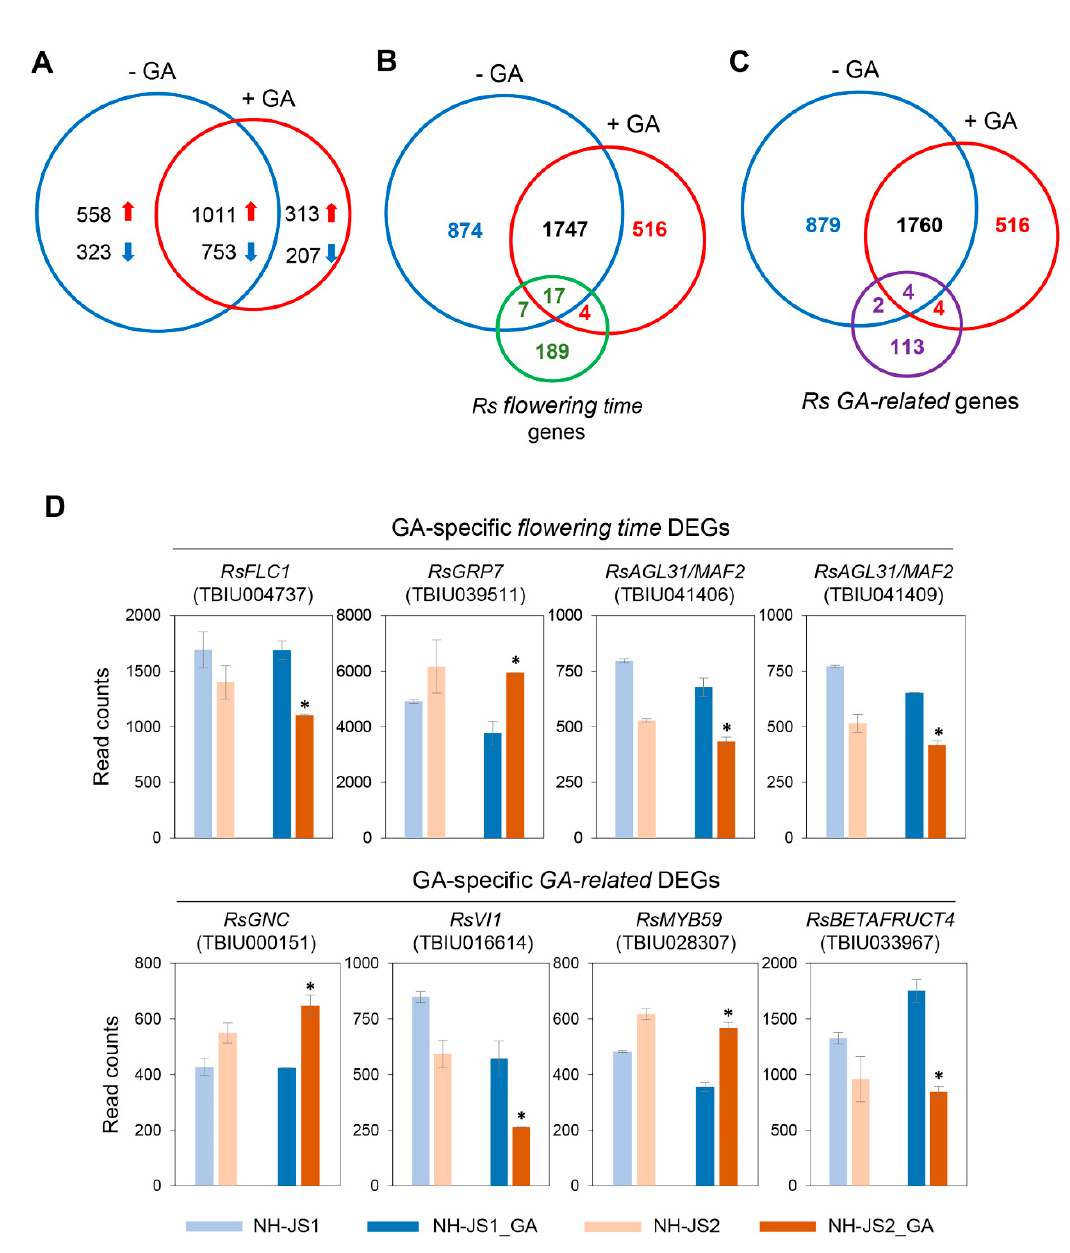
Figure 4. Comparative analysis of differentially expressed genes (DEGs) with and without gibberellin treatment in the two inbred radish lines ( | log 2 FC ≥ 0.6 | , false discovery rate (FDR) ≤ 0.01, read count ≥ 500). ( A ) Number of DEGs in the two lines with and without GA treatment. Red arrows, number of upregulated DEGs; blue arrows, number of downregulated DEGs. ( B ) The number of flowering time DEGs between two lines under GA treatment. Red, the number of flowering time DEGs after GA treatment. ( C ) The number of GA-related DEGs between two lines under GA treatment. Red, the number of GA-related DEGs after GA treatment. ( D ) RNA-sequencing results of flowering time and GA-specific DEGs. Asterisk means selected DEGs response to GA.